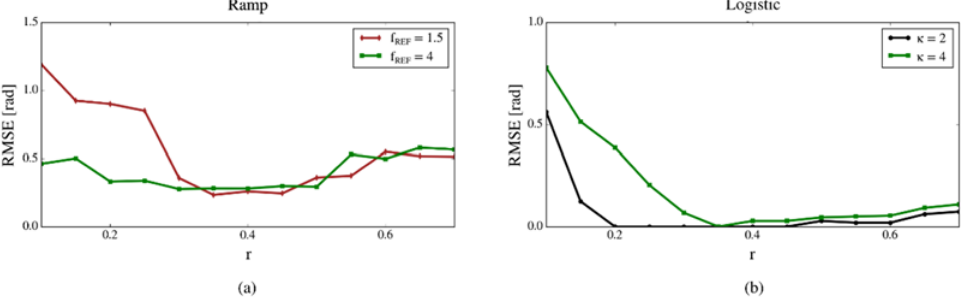
Figure 5. Sensitivity analysis with simulated data, impact of the demodulation patch radius r on the algorithm performance. RMSE of the demodulated unwrapped phase as a function of r . ( a ) Ramp gradient, ∆ f = 2 fringes/lobe (in red: f REF = 1.5 fringes/lobe; in green: f REF = 4 fringes/lobe); ( b ) Logistic gradient, ∆ f = 0.75 fringes/lobe and f REF = 4 fringes/lobe (in black: κ = 2; in green: κ =